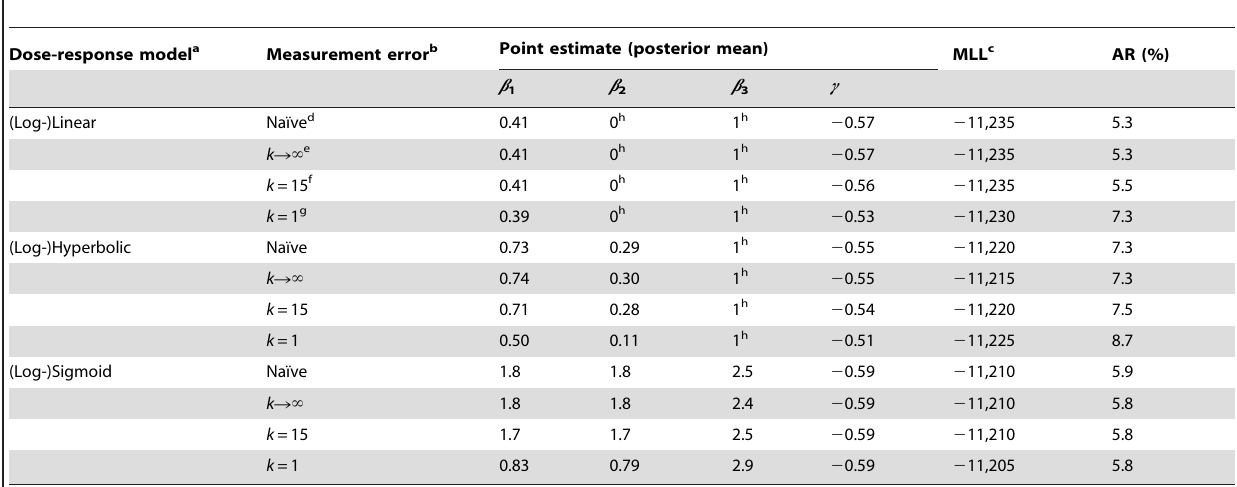
Table 4. Adjusted point parameter estimates, maximum log-likelihoods, and risk of mortality attributable to Onchocerca volvulus infection.